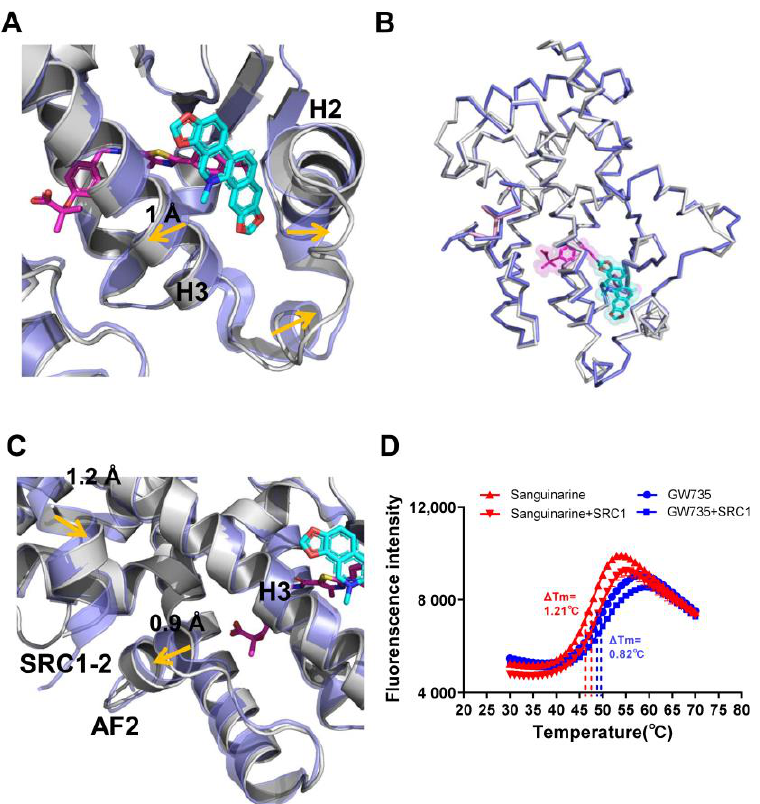
Figure 6. Conformational changes of PPARα induced by sanguinarine. (A – C) Superposition of the sanguinarine –PPARα structure (colored as in Figure 3) with the GW735 –PPARα structure (PDB ID: 2P54; blue, where GW735 is magenta). The alignment reveals shifts for helix 2, helix 3, AF2, and SRC1, induced by sanguinarine binding which is indicated by arrows. (D) Thermal shift assay fluorescence signals obtained for PPARα/γ– LBD with ligands and the co-activator peptide, SRC1. The results are the average of experiments performed in triplicate, with error bars indicating SDs.